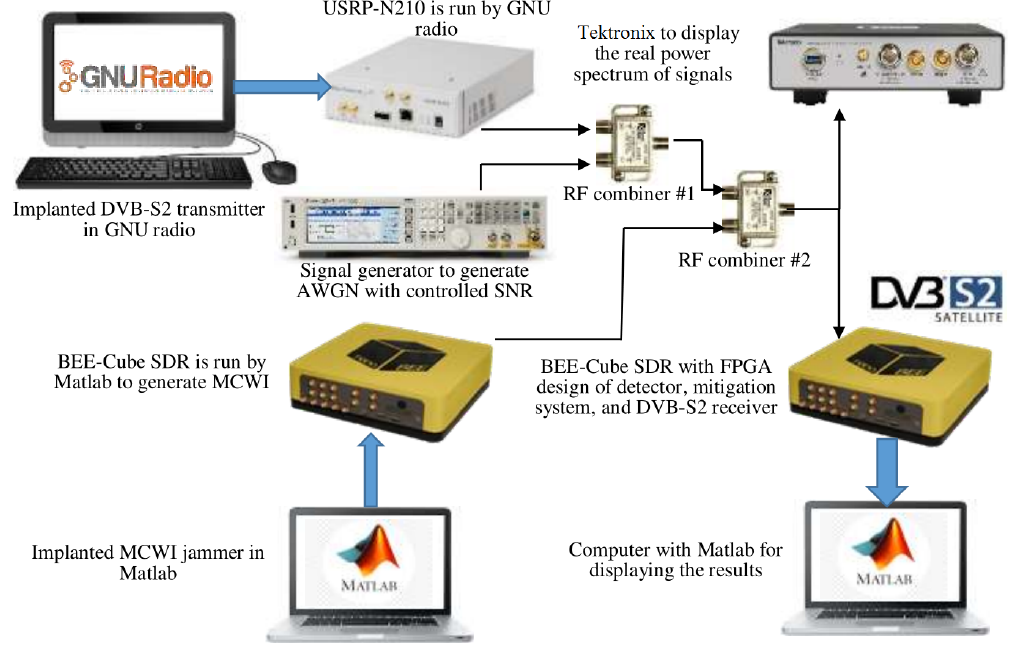
Figure 17. Block diagram of test bench set up for practical and real-time test. Table 3 represents the detector performance in the practical test. In this test, three hopping frequency CWIs are generated by the jammer. This test tries to explain the detec- tor capabilities in both weak signal detection and interferences with fast center variation.